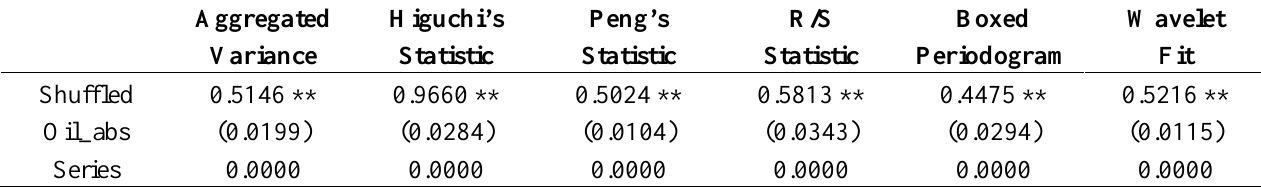
Table 4. Robustness analysis of the scaling exponent H models.